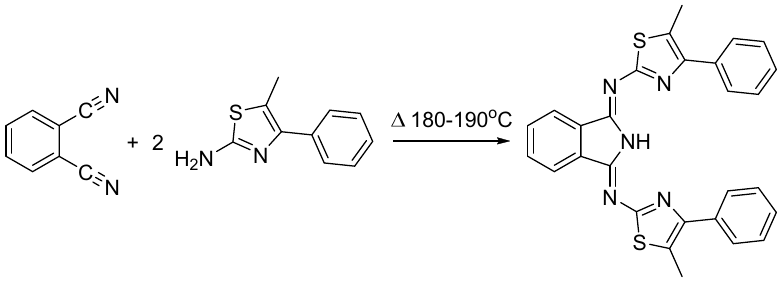
Figure 1. X-ray structure of 1 .